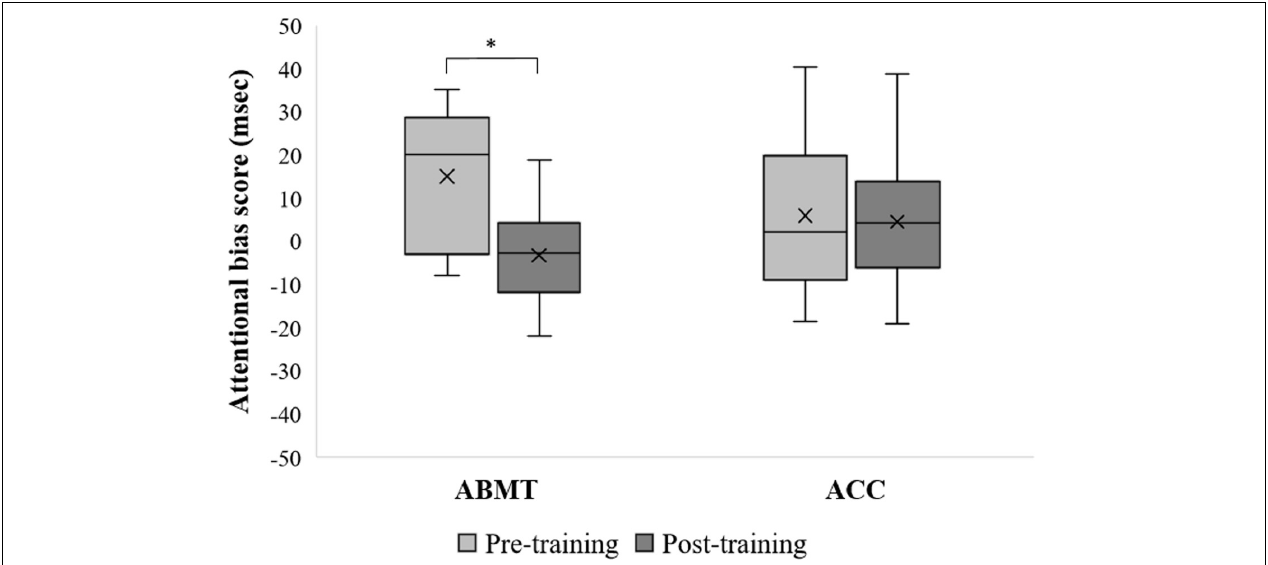
FIGURE 2 | Attentional Bias score (AB) values (msec) in attention bias modification training (ABMT) and Attention Control Condition (ACC) group, pre- and post-training. ANOVA revealed a significant Group × Time interaction effect ( p < 0.05). Cross represents the mean value, central band represent the median, bottom and top of the box represent the first and third quartile respectively, whiskers reflect the minimum and maximum of all the data. ∗ Post hoc Fisher’s LSD comparisons, p < 0.01.